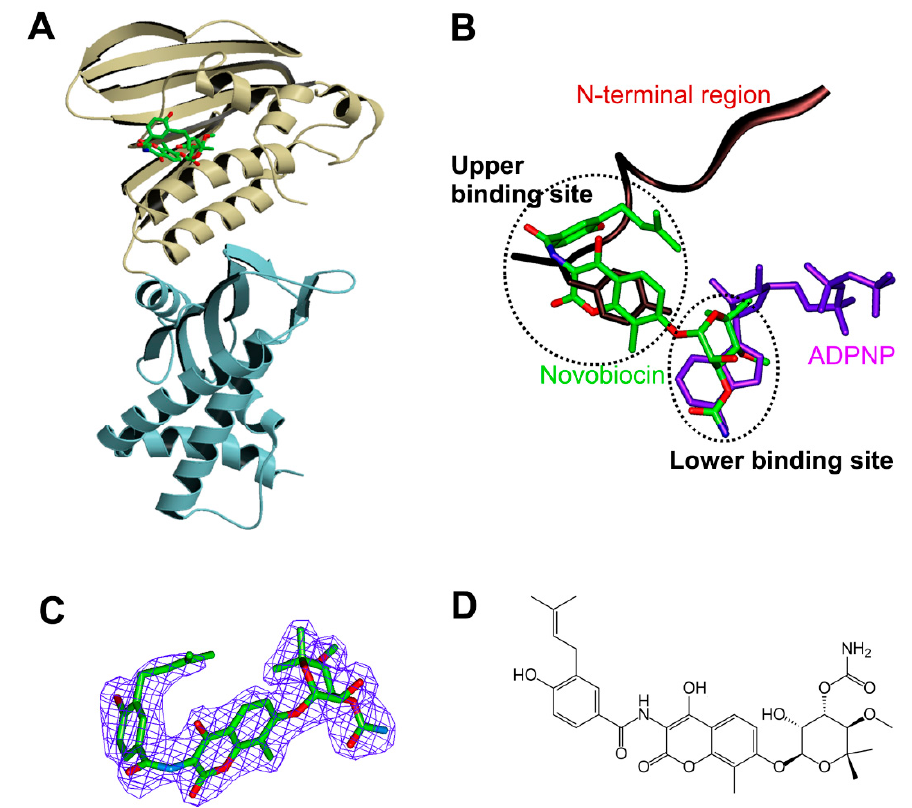
Figure 3. Structure of Xoo ParE in complex with novobiocin. ( A ) Overall structure of Xoo ParE in complex with novobiocin. Novobiocin (atomic color) is binding to domain 1. ( B ) Two distinct regions of the novobiocin binding site are indicate as dotted circles. Novobiocin in the complex structure of Xoo ParE is overlaid onto the dimeric structure of E. coli ParE in complex with ADPNP. The bound ADPNP and N-terminal region including the conserved tyrosine residue are colored purple and brown, respectively. ( C ) 2 fo–fc composite omit map (1.2 σ contour level) at novobiocin in the complex structure, calculated at 2.30 Å resolution. ( D ) Chemical structure of novobiocin.